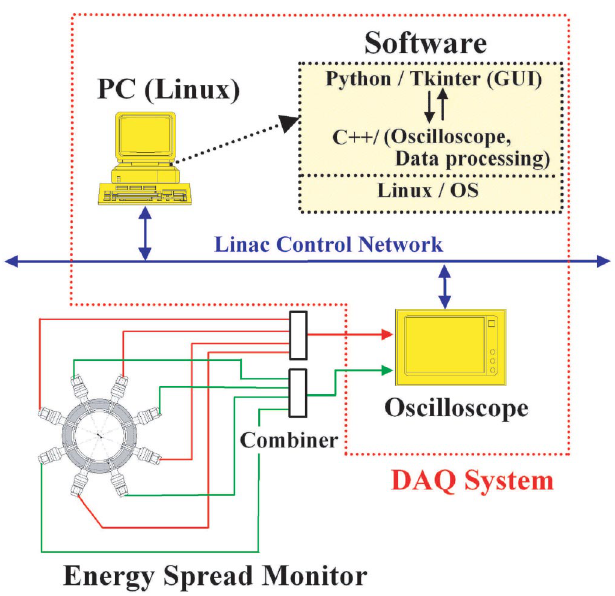
FIG. 2. (Color) Data-acquisition system of the energy-spread